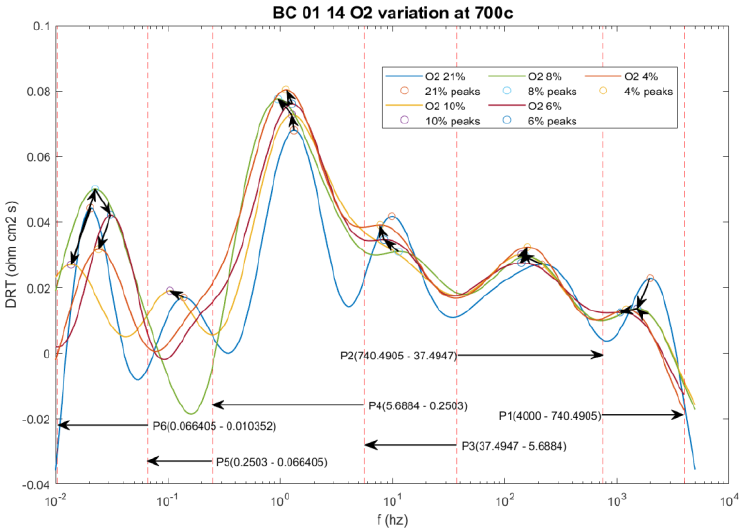
Figure 7. Tool user interface illustrating oxygen variation analysis.